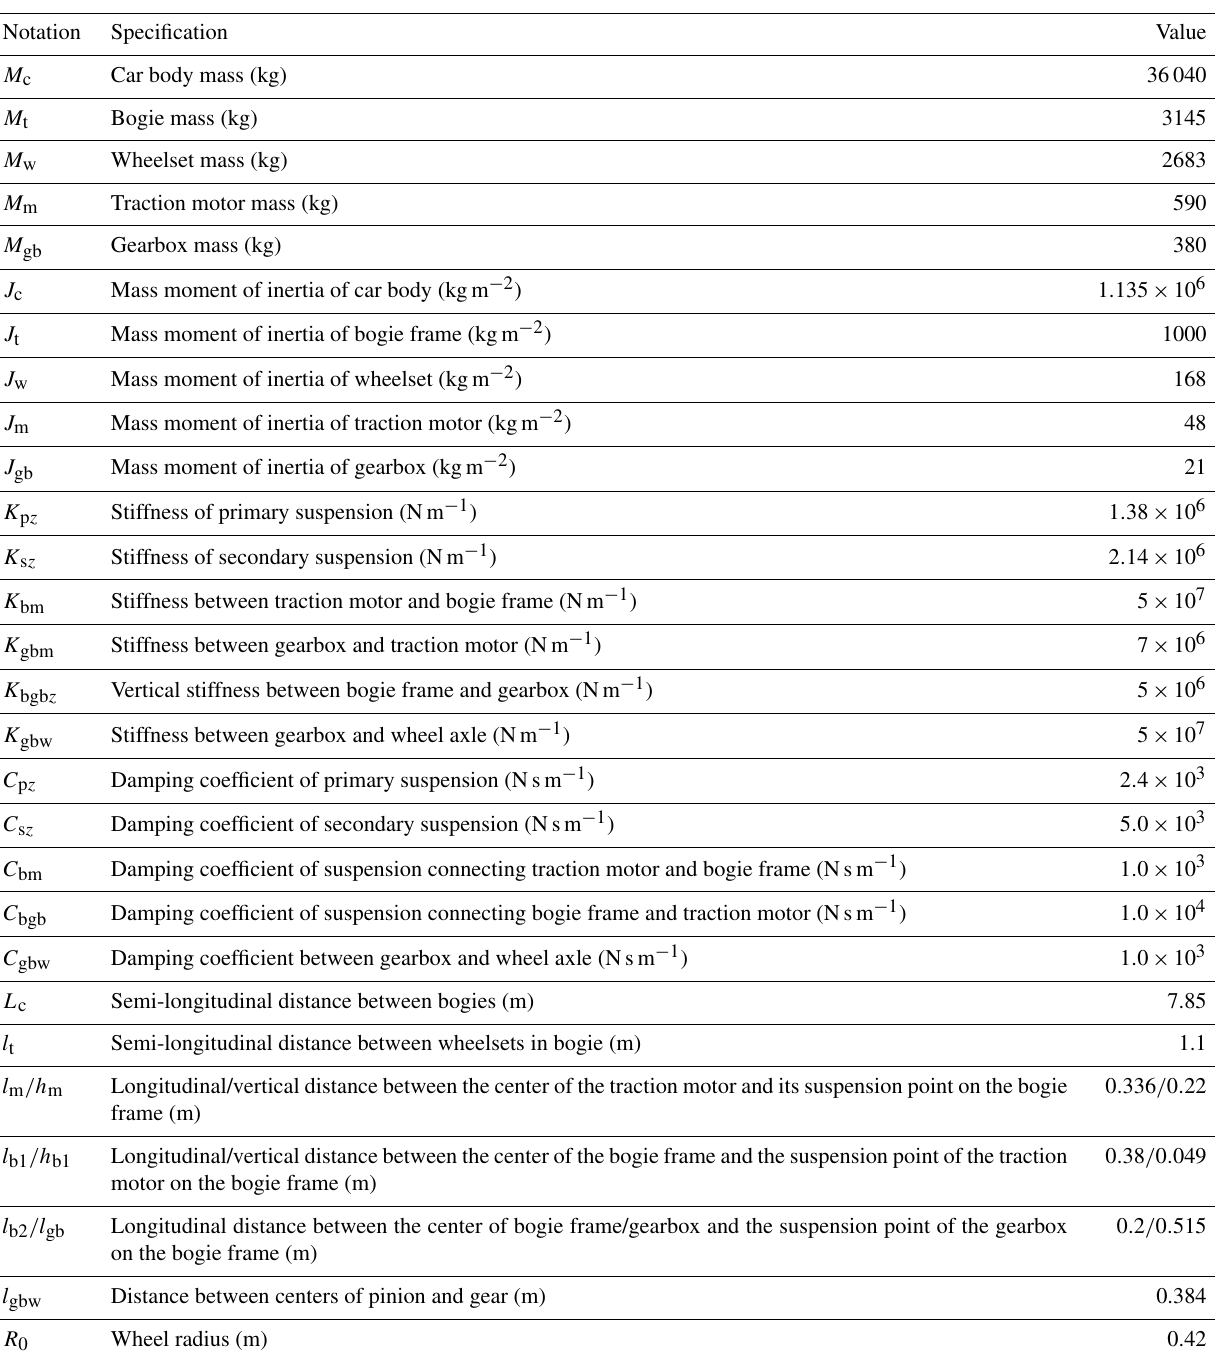
Table 2. Main parameters of the metro vehicle